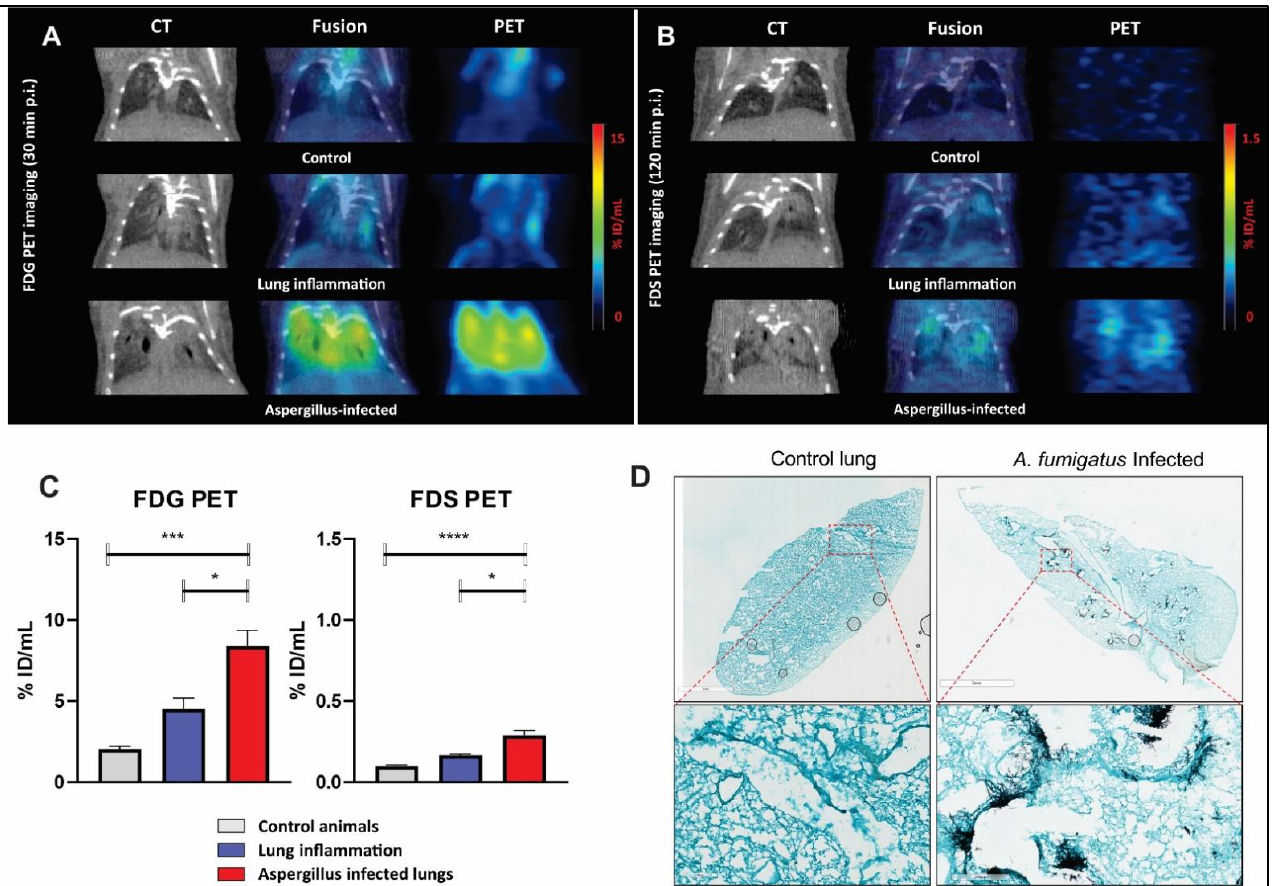
Figure 3. Static PET/CT imaging with 18 F-fluorodeoxyglucose (FDG) (30 min post injection) or 2-[ 18 F]-fluorodeoxysorbitol (FDS) (120 min post injection) in A. fumigatus infected mice compared with healthy controls and poly(I:C)-induced lung inflammation models. ( A , B ) Representative coronal sectional images of lung CT, PET, and PET/CT fusion are shown. ( C ) Quantified uptake of FDG or FDS in the lungs of control, lung inflammation, or A. fumigatus infected mice. ( D ) GMS staining of lung slices from a control mouse and an A. fumigatus infected mouse on day 3 after infection. Scale bars, 2 mm (upper row panels) and 200 µm (lower row panels). Data are expressed as means ± SEM. *, p < 0.05. ***, p < 0.001. ****, p < 0.0001. (%ID/mL: %Injected dose/mL).